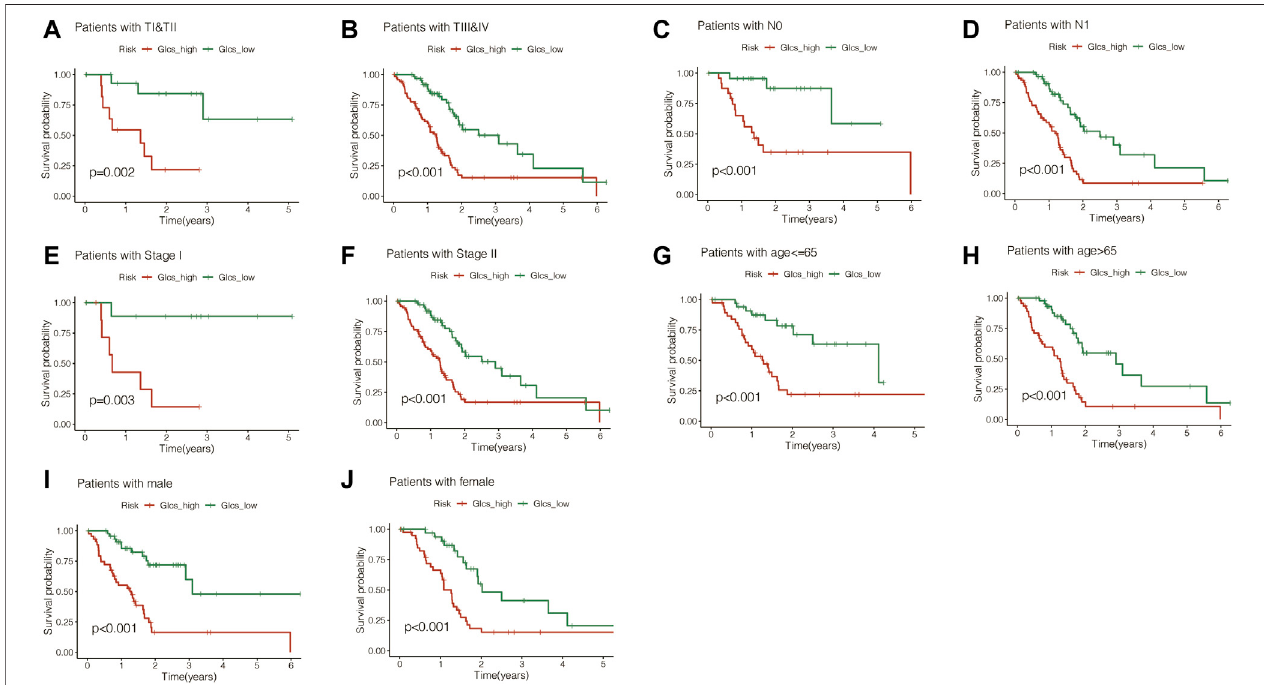
FIGURE 5 | Gene signature is suitable for different clinical patients. (A) Among the TI and TII stage PC patients, the prognosis of the high-GLCS group was worse ( p = 0.002). (B) Among the TIII&TIV stage PC patients, the prognosisofthe high-GLCS group wasworse ( p < 0.001). (C) Among the PCpatientswith N0, the prognosis of the high-GLCS group was worse ( p < 0.001). (D) Among the PC patients with N1, the prognosis of the high-GLCS group was worse ( p < 0.001). (E) Among PC patientswithstageI,theprognosisofthehigh-GLCSgroupwasworse( p =0.003). (F) AmongPCpatientswithstageII,theprognosisofthehigh-GLCSgroupwas worse ( p < 0.001). (G) Among PC patients with age < =65, the prognosis of the high-GLCS group was worse ( p < 0.001). (H) Among PC patients with age > 65, the prognosisof the high-GLCS group was worse ( p < 0.001). (I) Among male PC patients, the prognosis ofthe high-GLCS group wasworse ( p < 0.001) (J) Among female PC patients, the prognosis of the high-GLCS group was worse ( p <